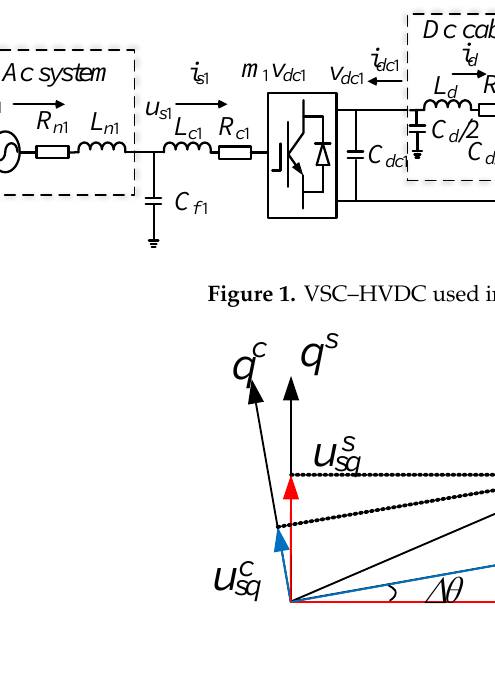
Figure 1. VSC – HVDC used in AC grid interconnection.